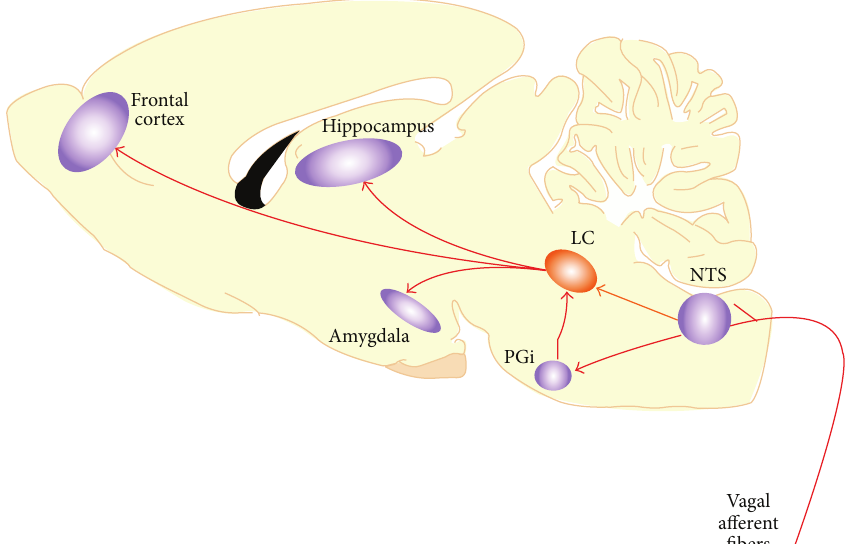
Figure 2: Schematic diagram depicting the activation of central structures through noradrenergic projections from the locus coeruleus (LC) in the rat brain. The nucleus tractus solitarius (NTS) receives peripheral input via the vagus nerve which is activated after stressful or emotionally arousing experiences